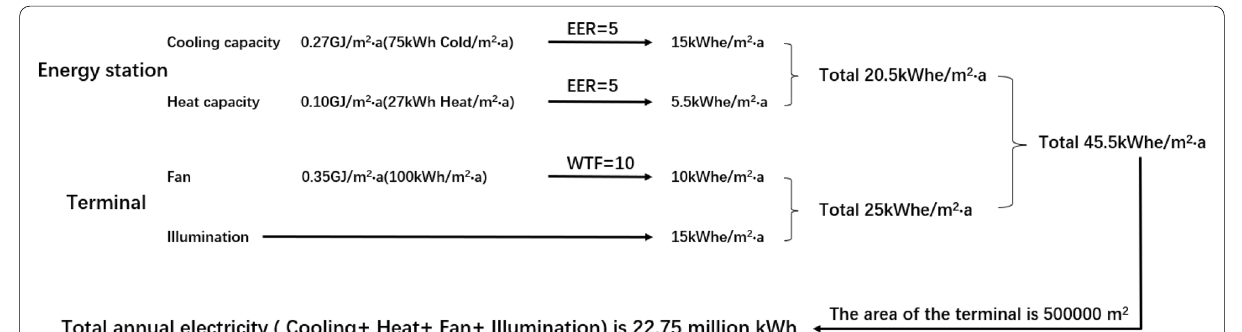
Fig. 12 Energy demand map of the site with the zero-carbon goal